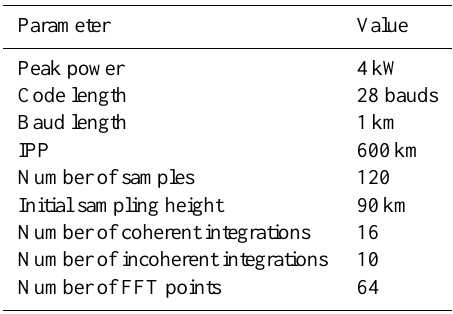
Table 1. Typical radar parameters for observations of 150km echoes.